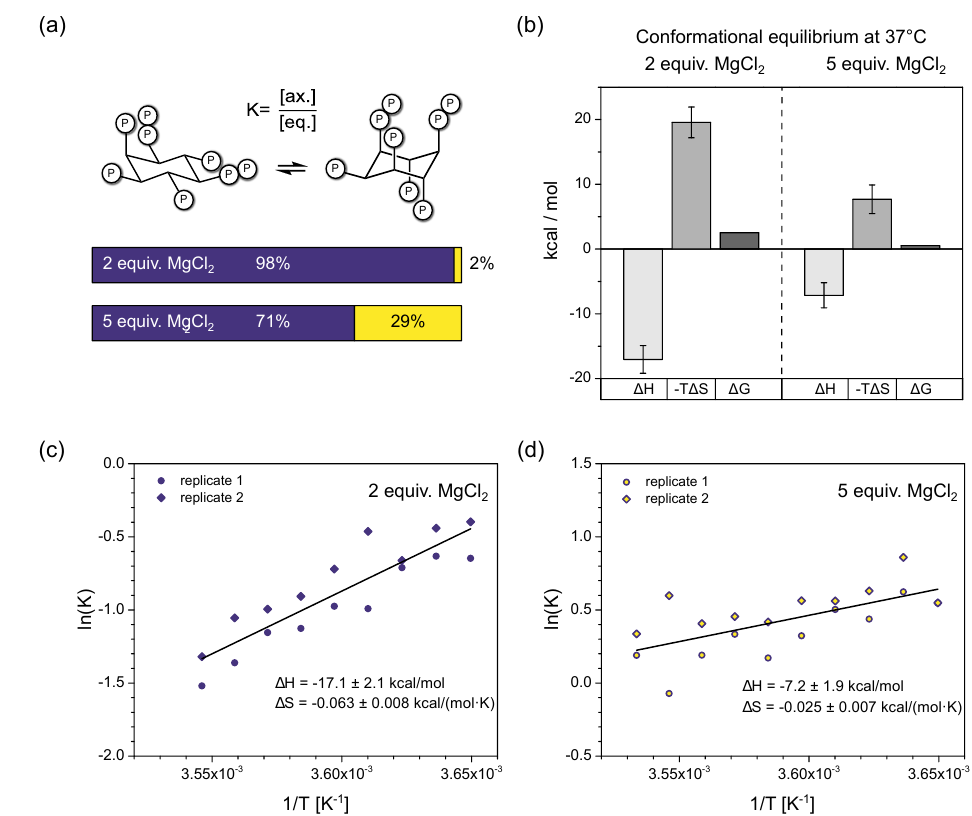
Figure 4. Thermodynamic analysis of InsP 8 conformational equilibrium. ( a ) Proportions of axial vs. equatorial conformer in the presence of 2 equiv. vs. 5 equiv. Mg 2+ , according to Gibbs-Helmholtz equation and thermodynamic parameters from ( b ). ( b ) Results of van’t Hoff analysis. Transition from eq. to ax. conformation is an exothermic process. While both entropic and enthalpic contributions are decreased by additional Mg 2+ , overall, the equilibrium is shifted toward ax. conformation. ( c , d ) Van’t Hoff plots of InsP 8 conformational equilibrium at pH 7.4 in the presence of ( c ) two equivalents, ( d ) five equivalents MgCl 2 and physiological background of 130 mM KCl and 10 mM NaCl. Tempera- ture range: 274–283 K. 1 H, 13 C-HMQC-NMR spectra were integrated to obtain the ratio of eq. to ax. conformer, i.e., the equilibrium constant K of the conformational equilibrium. Two replicates were treated as one for the linear regression. Thermodynamic parameters are reported ± standard error of